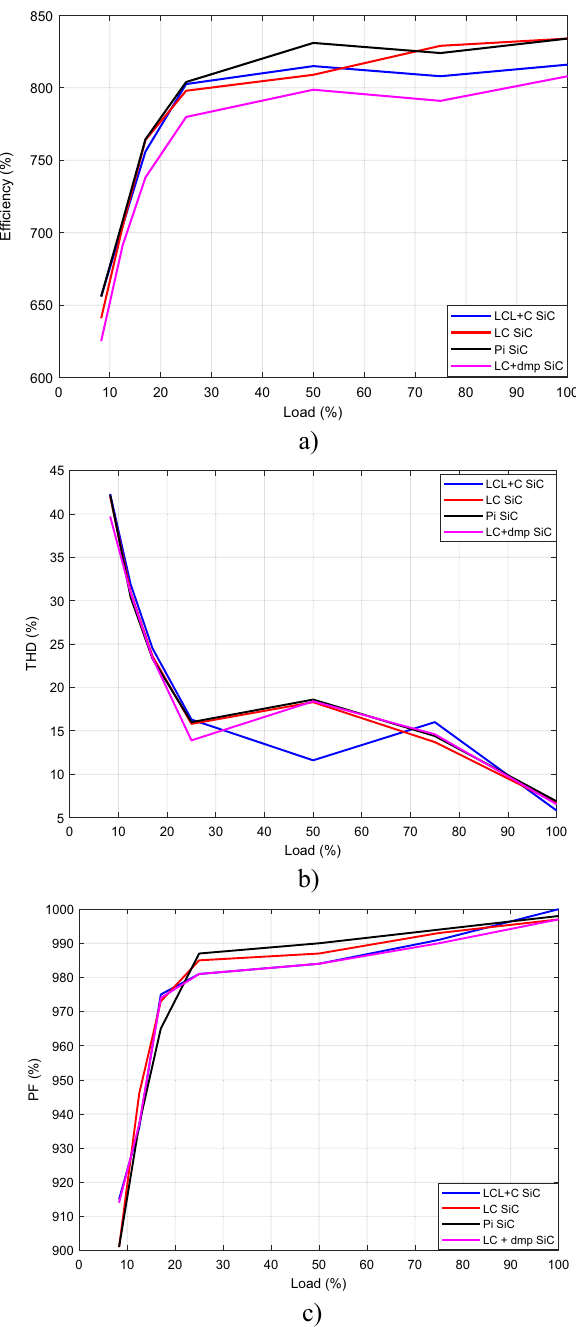
Figure 38. ( a ) Efficiency, ( b ) THD, ( c ) PF for SiC Mosfet by load